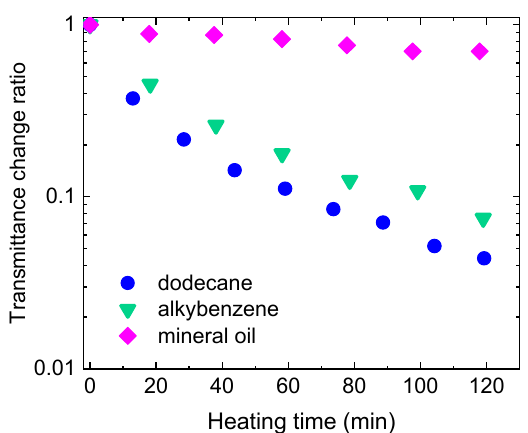
Figure 22. Reduction in THz transmission due to oxidation in three insulating oils. Adapted from [159].